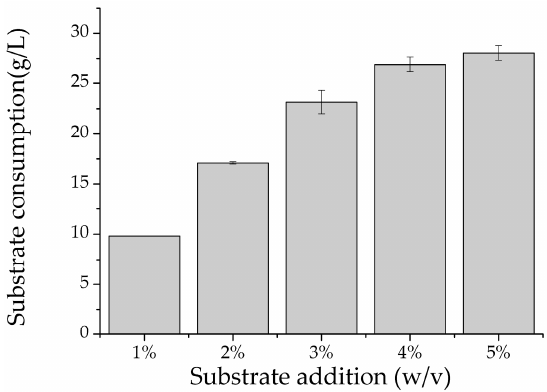
Figure 7. Optimization of substrate addition in terms of substrate consumption with polyphosphate dependent mannose kinase, and MgCl 2 (5 mM) at 30 °C at pH 8.5. As the amount of substrate increased, the substrate consumption also increased.